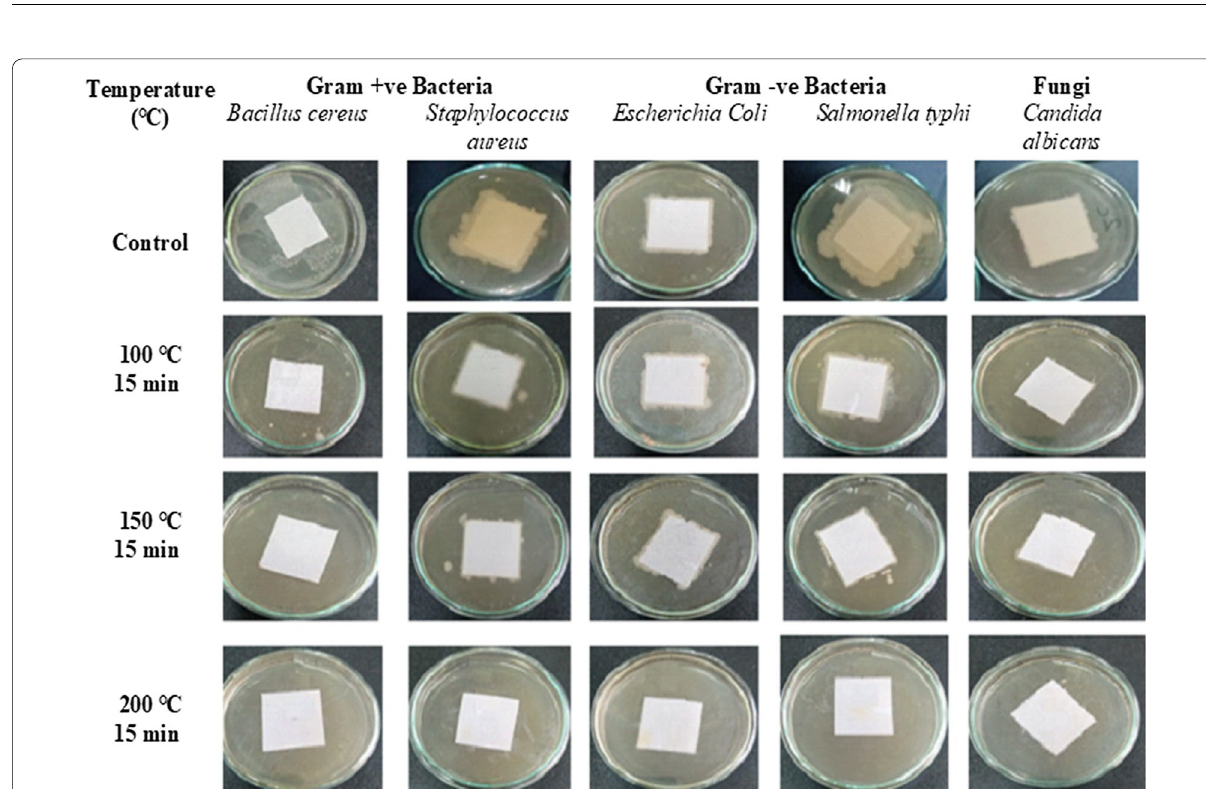
Fig. 4 The efficiency of dry heating for 15 min in the sterilization of pathogenic contaminated